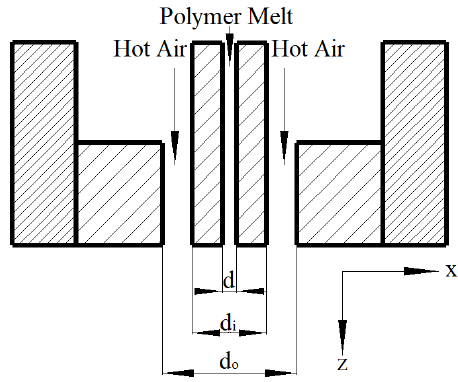
Figure 3. Annular